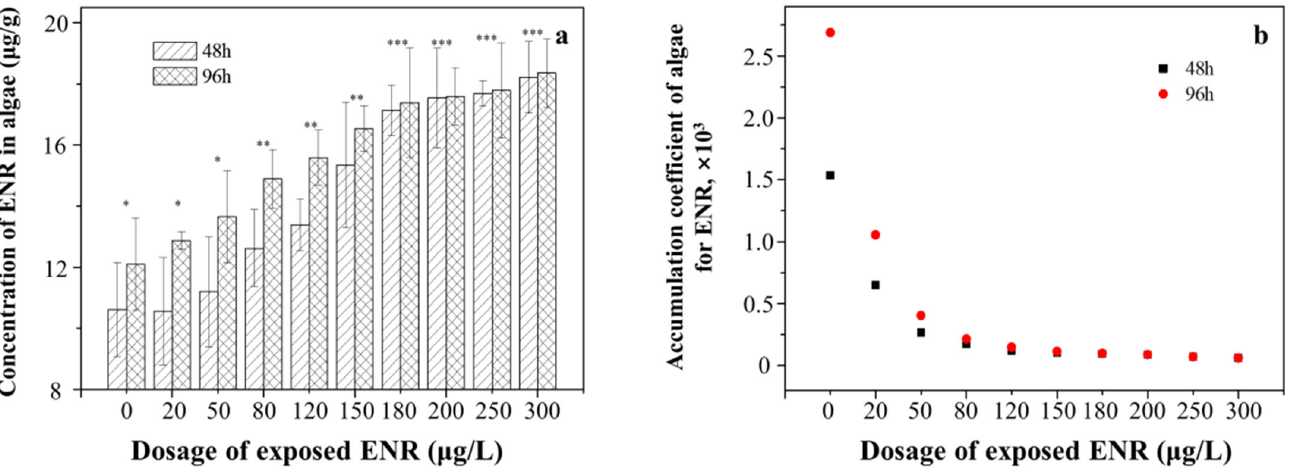
Figure 2. The accumulation of ENR in algae under different exposure dosages at 48 h and 96 h. ( a ) The amount of accumulated ENR; ( b ) the accumulation coefficient of ENR. The number of “*” was referred as the significant between-group variance. The same number means no significant difference, whereas the different number means the significant difference.